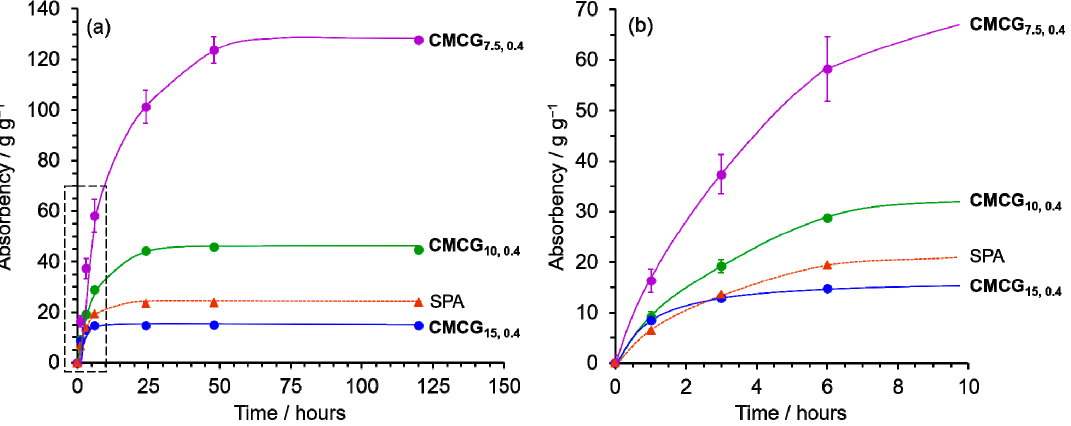
Figure 2. Time-dependence of the absorbency of the CMCGs and sodium polyacrylate (SPA) ( a ) toward phosphate-buffered saline (PBS) and ( b ) initial stage of the absorbency.